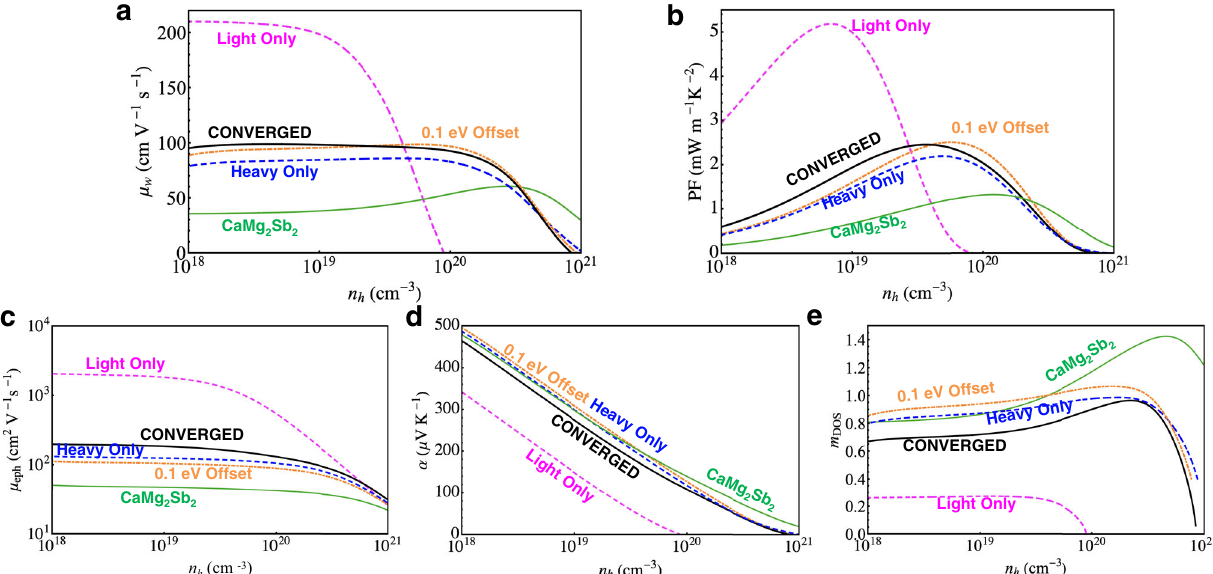
Fig. 2 Calculated e-ph limited p -type properties of the band con fi gurations depicted in Fig. 1c at 600 K. a Weighted mobility, ( b ) the power factor, ( c ) mobility, ( d ) the Seebeck coef fi cient, and ( e ) the DOS effective mass.